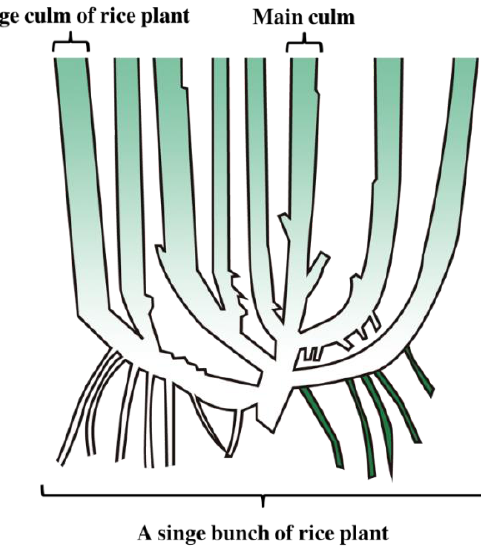
Figure 3. The standardized rice transfer interval due to agricultural mechanization.